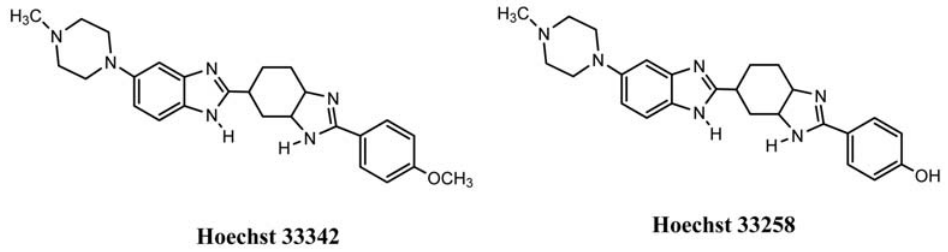
Fig. 1. Examples of topoisomerase inhibitors containing benzimidazole